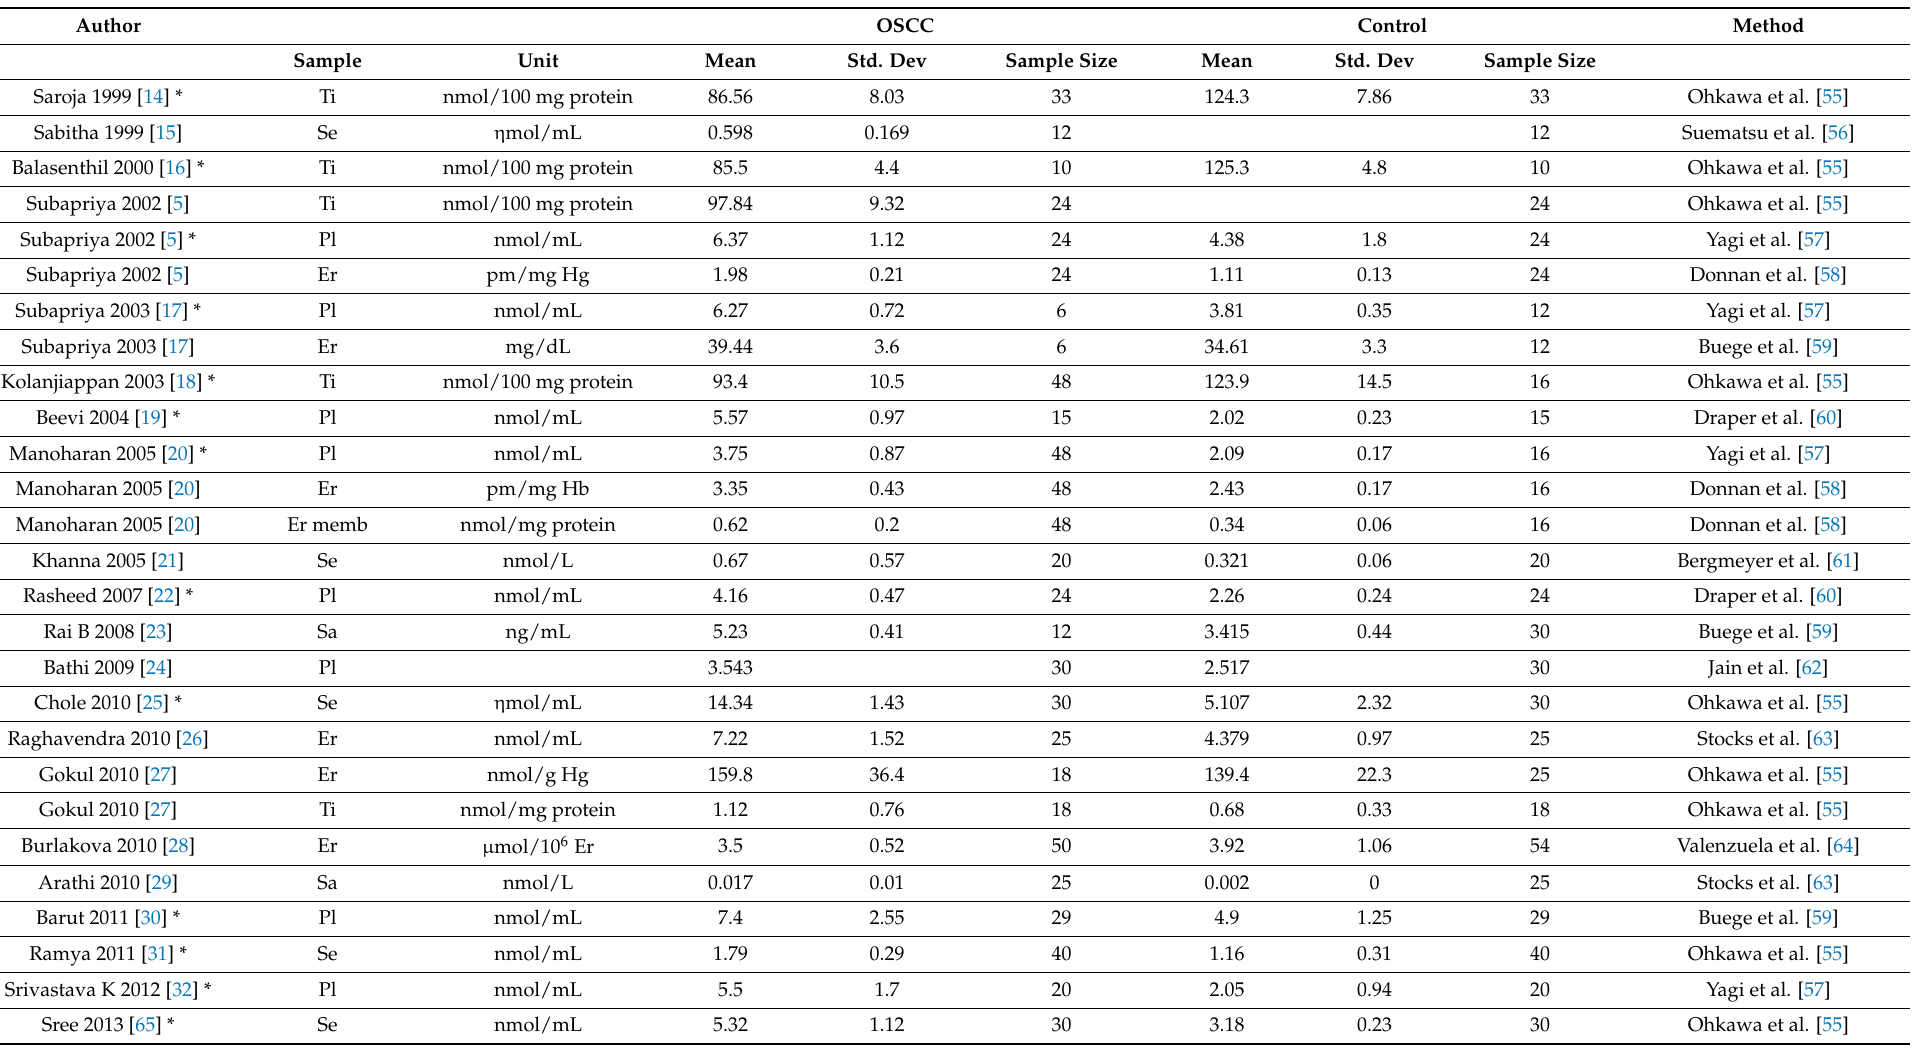
Table 2. The levels of MDA in various biological samples between healthy controls and patients with OSCC of studies included in the qualitative